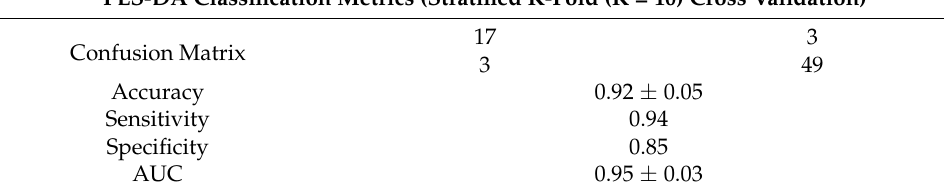
Figure 4. ( a ) Scatter plot of the first two PLS latent variables and ( b ) receiver operating characteristics (ROC) curve from PLS-DA classification of eczema ( n = 52) and healthy ( n = 20) subjects. Table 2. Classification metrics from the PLS-DA binary classification model using the stratified K-fold (K = 10) cross validation method for eczema ( n = 52) and healthy ( n = 20)